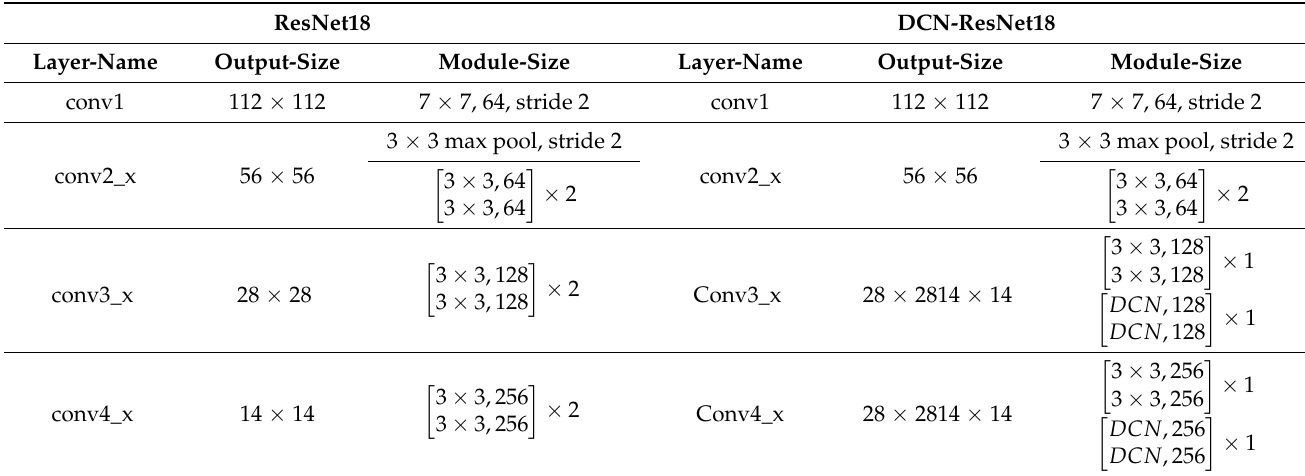
Table 1. Comparison of the structure of DCN-ResNet18 network and ResNet18